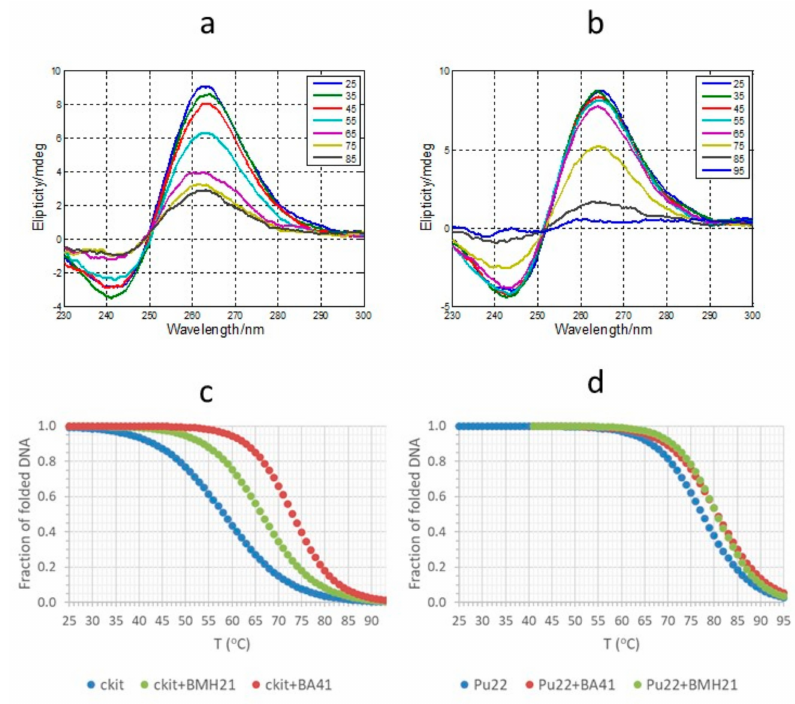
Figure 1. Circular dichroism (CD) spectra recorded along the thermally induced unfolding of c-kit21T12T21 ( a ) and Pu22T14T23 ( b ). Fraction of folded DNA vs. temperature in the absence and presence of the ligands calculated from the CD trace at 262 nm: ( c ) BMH-21 ( 1 ) and BA-41 ( 2 ) with c-kit21T12T21, and ( d ) BMH-21 ( 1 ) and BA-41 ( 2 ) with Pu22T14T23. The medium consisted of 5 mM phosphate bu ff er (pH 7.0) and 20 mM KCl. DNA and ligand concentrations were 1 µ M and 3 µ M,